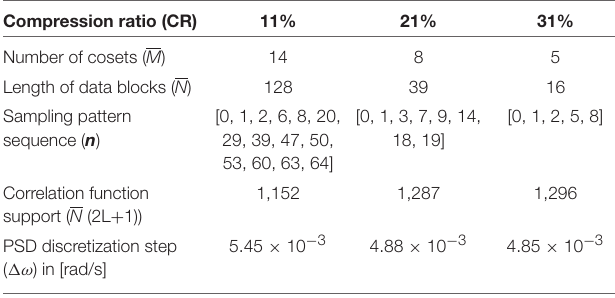
TABLE 1 | Adopted multi-coset sampling and PSBS